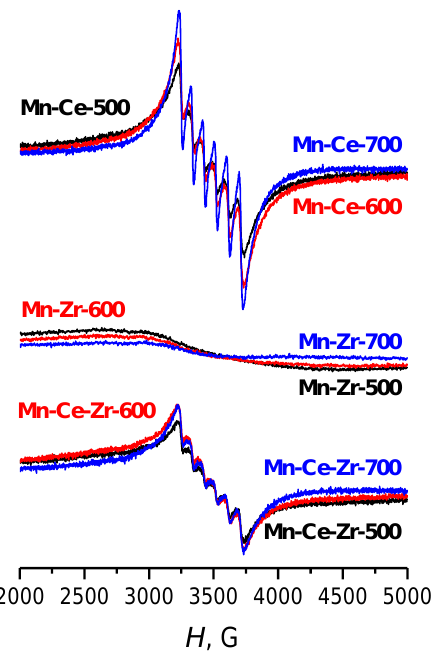
Figure 5. EPR spectra of Mn-Ce, Mn-Zr and Mn-Zr-Ce catalysts, calcined at 500 °C, 600 °C and 700 °C.